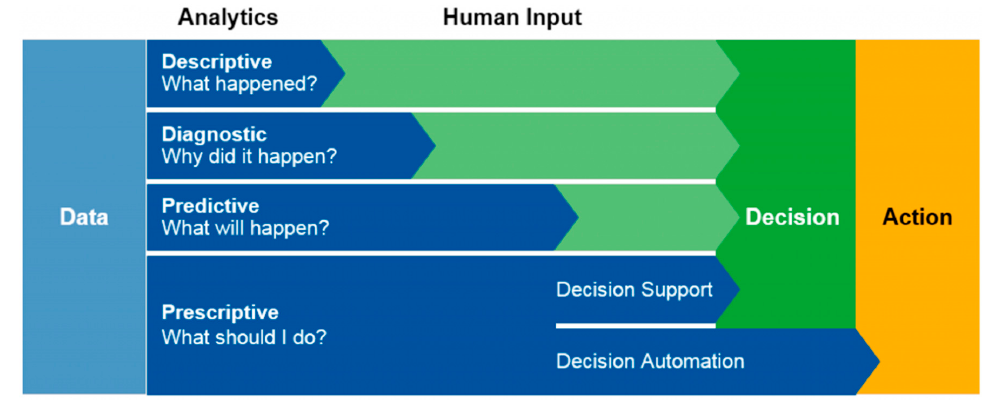
Figure 1. Gartner analytics capabilities framework [34].